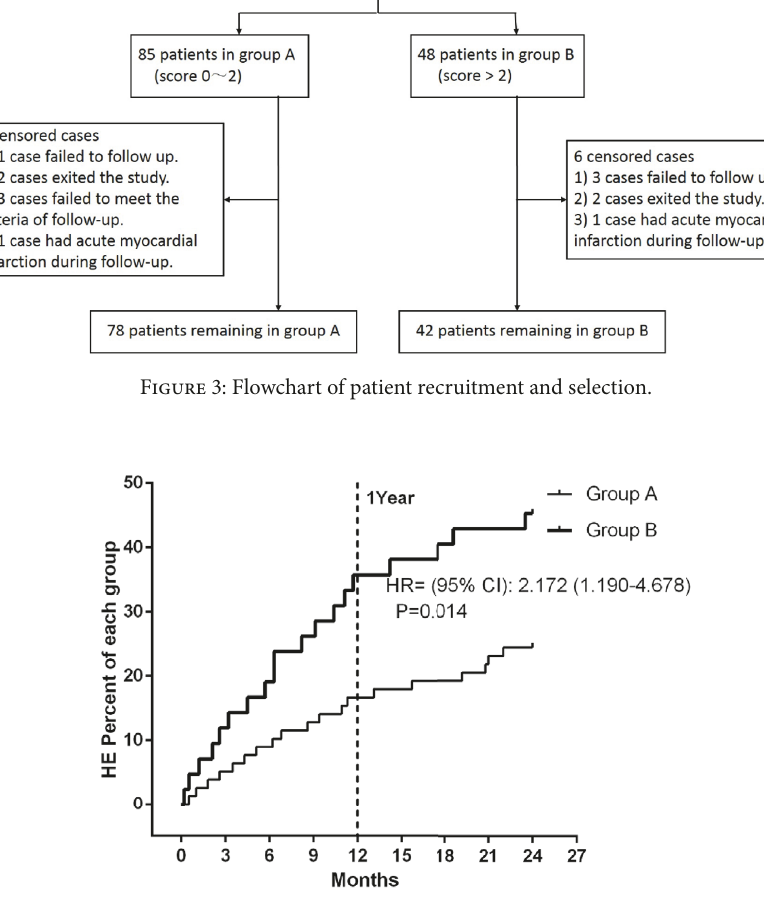
Figure 4: HE cumulative risk was estimated by Kaplan-Meier curves. Log-rank (Mantel-Cox) test was used to calculate the hazard ratio. Compared to group A, group B had a significantly increased risk of HE during the study (p <